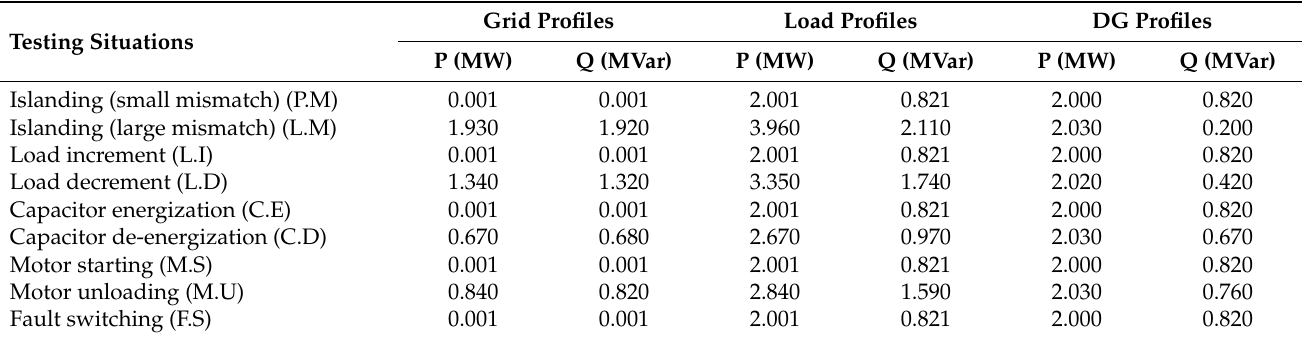
Figure 3. Comparison of parameters magnitudes/phase vs. considered islanding and non-islanding event ( a ) voltage ( b ) frequency ( c ) active power ( d ) reactive power ( e ) power factor ( f ) voltage phase angle. Table 2. Testing scenarios.